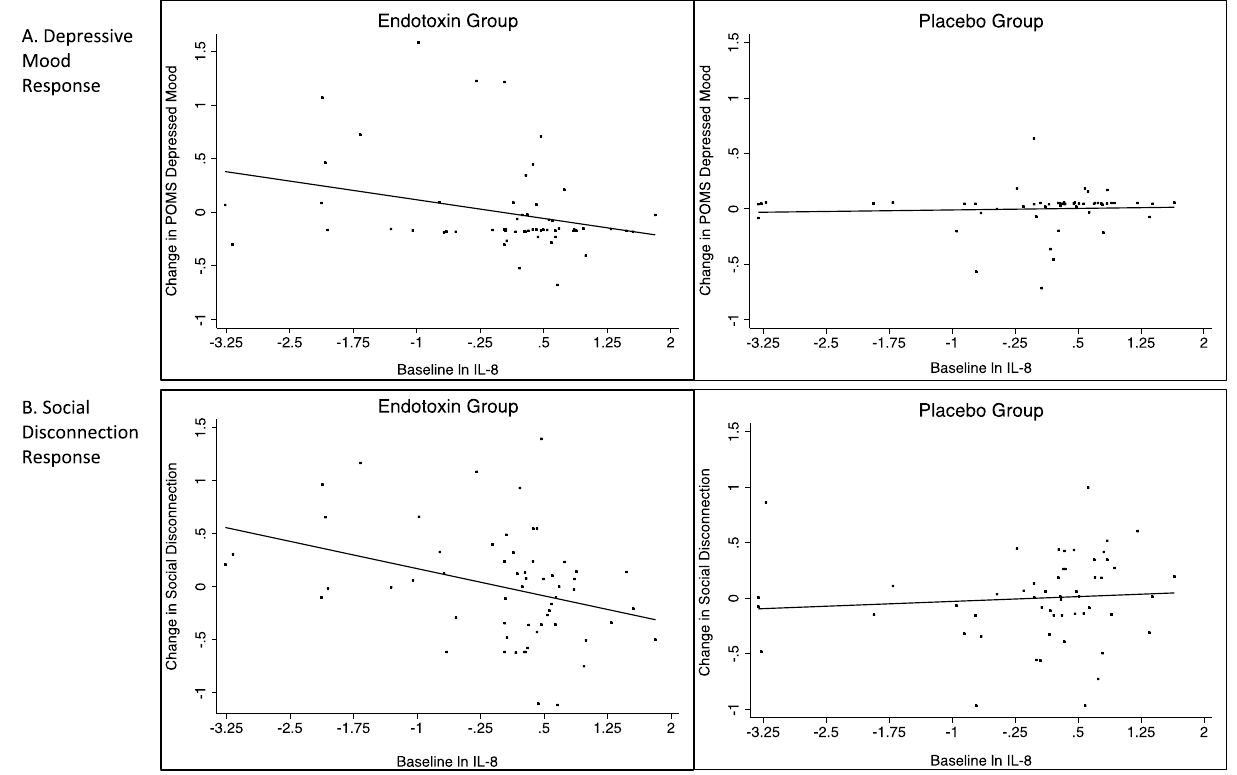
Figure 1. Association between baseline IL-8 and change in depressive mood ( A ) and social disconnection ( B ) Baseline ln IL-8 was significantly associated with depressive mood response and social disconnection response within the endotoxin group ( p ’s < .03) but not the placebo group ( p ’s > .69). Analyses are adjusted for age. See Table 1S for full statistical